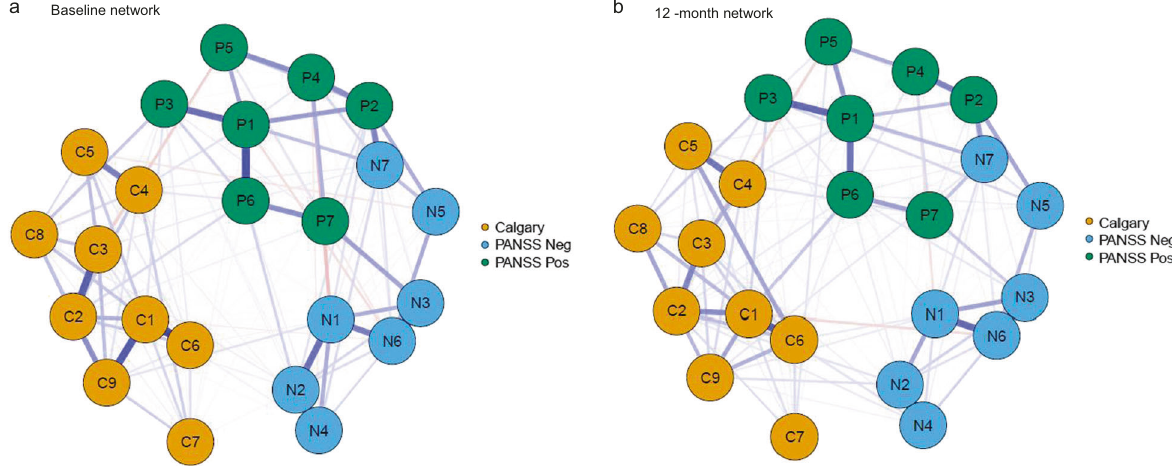
Fig. 1 Symptom network maps across timepoints. A network structure for baseline is depicted in 1(a), and 1(b) for the 12 month network. Nodes (circles) represent individual symptoms. Orange nodes represent depressive items from the Calgary Depression Scale for Schizophrenia (CDSS). Blue nodes represent 7 negative symptoms from the PANSS scale, and green nodes represent items from the PANSS positive scale. Edge weights (lines) represent the strength of association between symptoms. Blue edges represent positive associations and red edges represent negative associations; denser lines represent stronger connections. P1_ = Delusions; P2 = Conceptual Organization; P3 = Hallucinatory Behaviour; P4 = Excitement; P5 = Grandiosity; P6 = Suspiciousness/Persecution; P7 = Hostility; N1 = Blunted Affect; N2 = Emotional Withdrawal; N3 = Poor Rapport; N4 = Passive/Apathetic Social Withdrawal; N5 = Dif fi culty in Abstract Thinking; N6 = Lack of Spontaneity and Flow of Conversation; N7 = Stereotyped Thinking; C1 = Depression; C2 = Hopelessness; C3 = Self Depreciation; C4 = Guilt Ideas of Reference; C5 = Pathological Guilt; C6 = Morning Depression; C7 = Early Awakening; C8 = Suicide; C9 = Observed